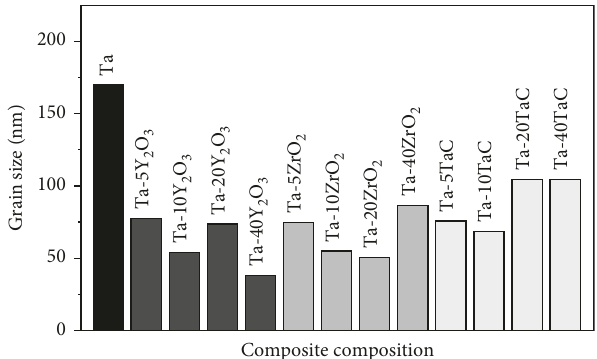
Figure 8: Average grain size for the Ta-xY � 0, 5, 10, 20, and 40 wt.%); data measured 2 O 3 , Ta-xZrO 2 , and Ta-xTaC bulk nanocomposites ( x using AFM (not all AFM images and grain size distributions have been shown in this